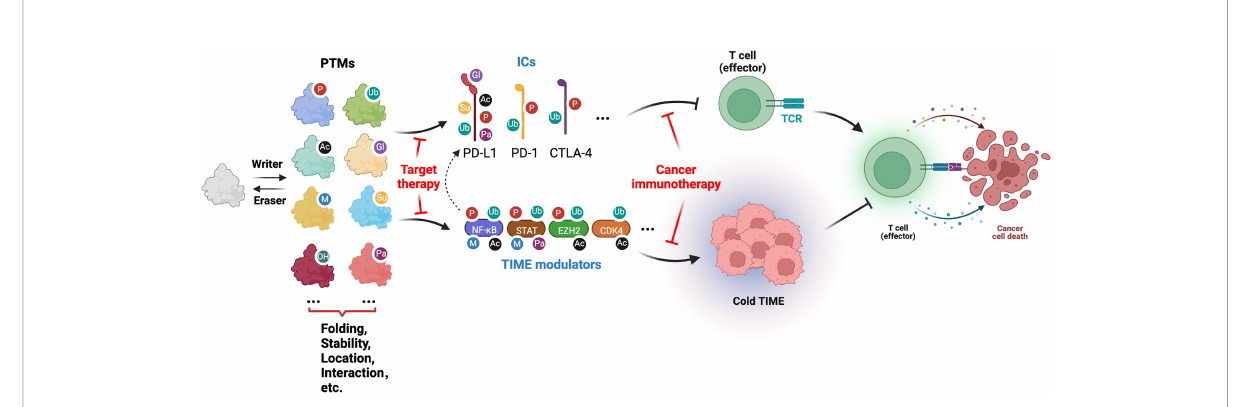
FIGURE 1 Illustration of PTMs involved in cancer immune and immunotherapy by modifying ICs and TIME modulators (generated with